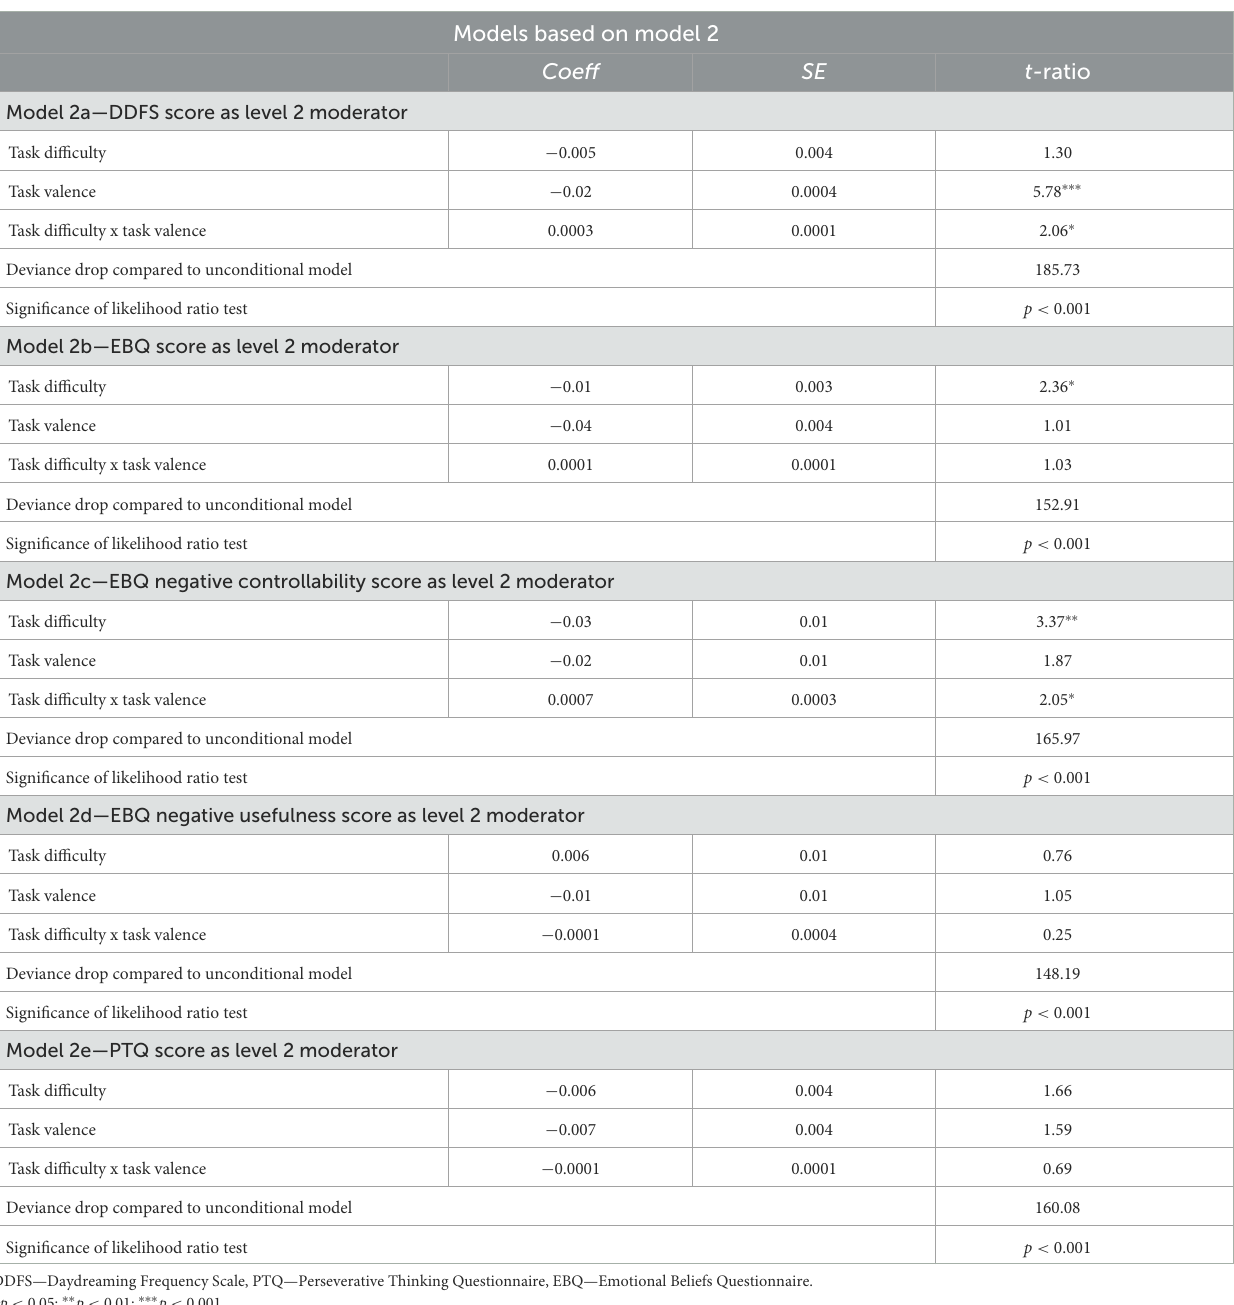
TABLE 4 Testing level 2 variables as moderators of level 1 interactions in Model 2. TUT intensity is the outcome in all of the models. Models based on model